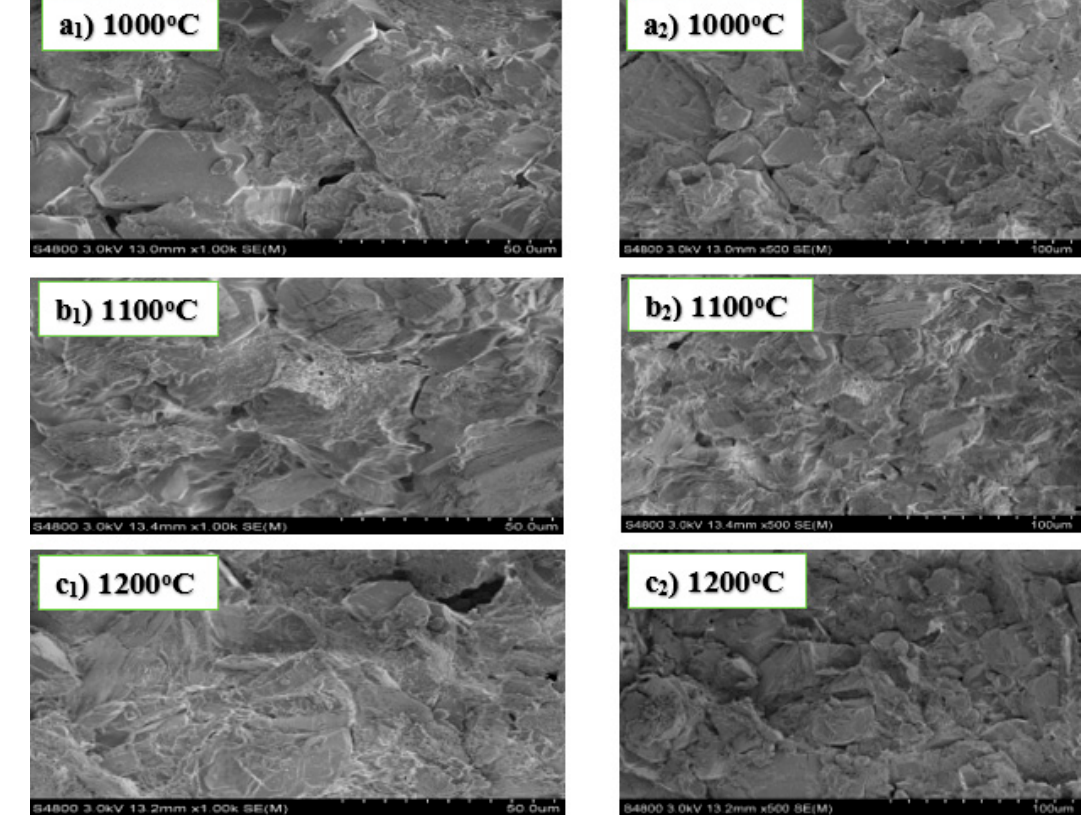
Figure 1. SEM images of experiment A sintered at 1000 °C ( a 1 , a 2 ), 1100 °C ( b 1 , b 2 ), and 1200 °C ( c 1 , c 2 ).